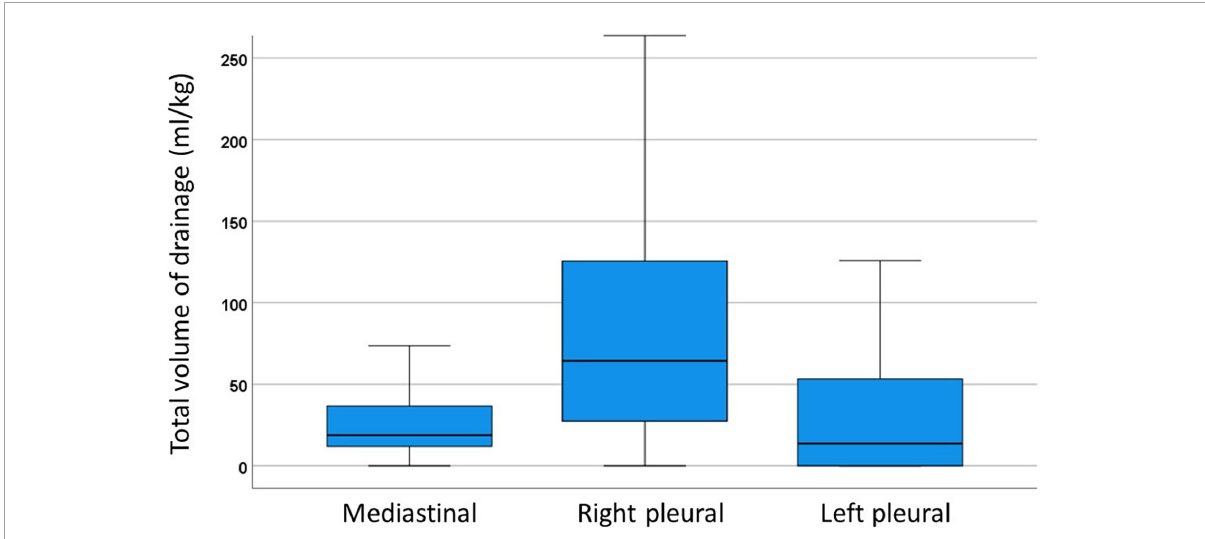
FIGURE1 Box-and-whiskers dot plots showing total volume of drainage in right pleural, left pleural and mediastinal drainage. The upper and lower whiskers mark the minimum and maximum values, the upper and lower borders of the box represent the upper and lower quartiles, and the middle horizontal line represents the median.